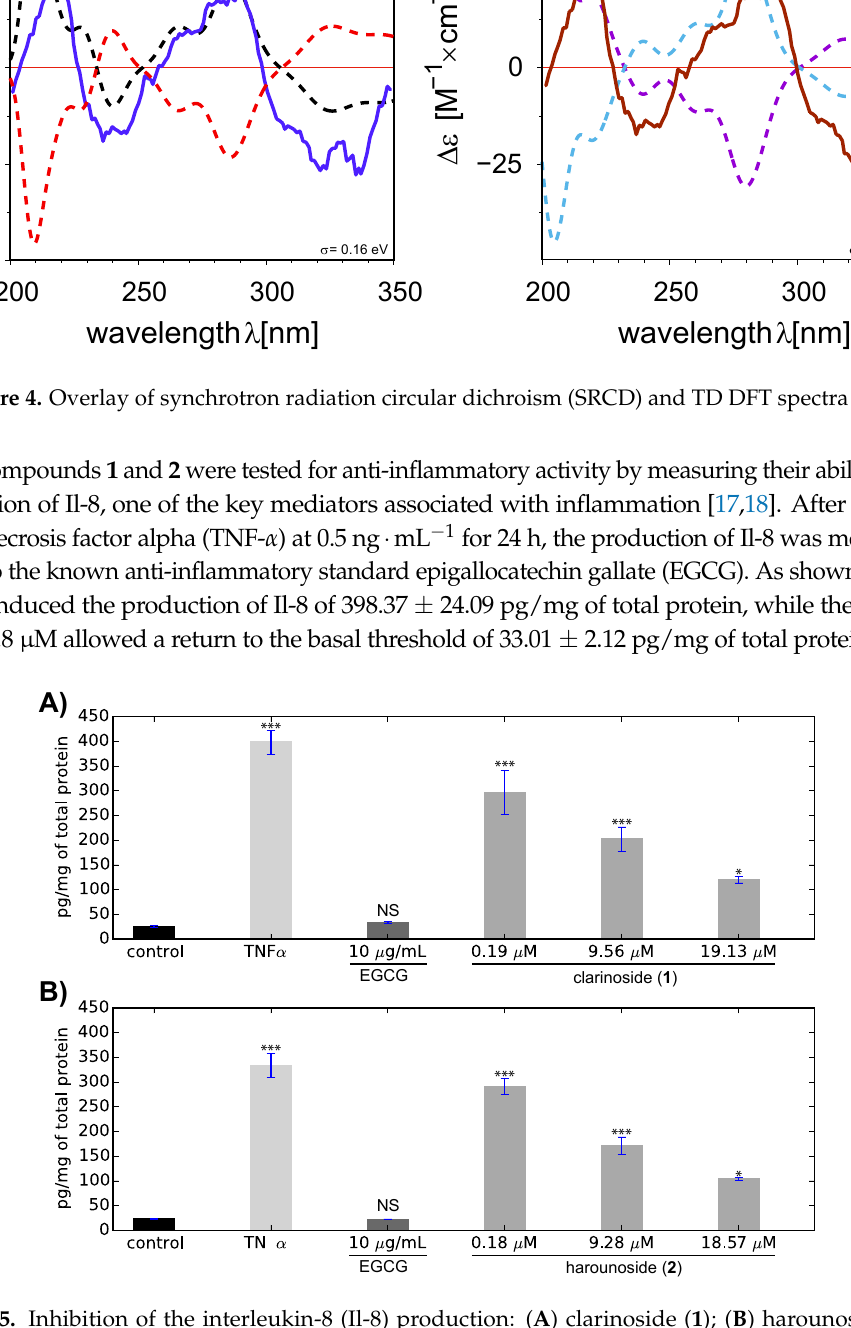
Figure 5. Inhibition of the interleukin-8 (Il-8) production: ( A ) clarinoside ( 1 ); ( B ) harounoside ( 2 ). Means ± SD are shown. NS: not significant; * p < 0.05; *** p <